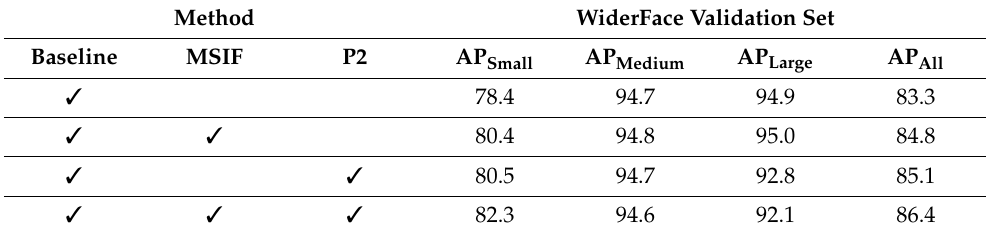
Table 3. Ablation study for the proposed P2 and MSIF methods with respect to face sizes. AP Small , AP Medium , and AP Large represent the AP performance for Small, Medium, and Large face sub- datasets. AP All is the AP performance for all faces in WiderFace Validation dataset without the size-based